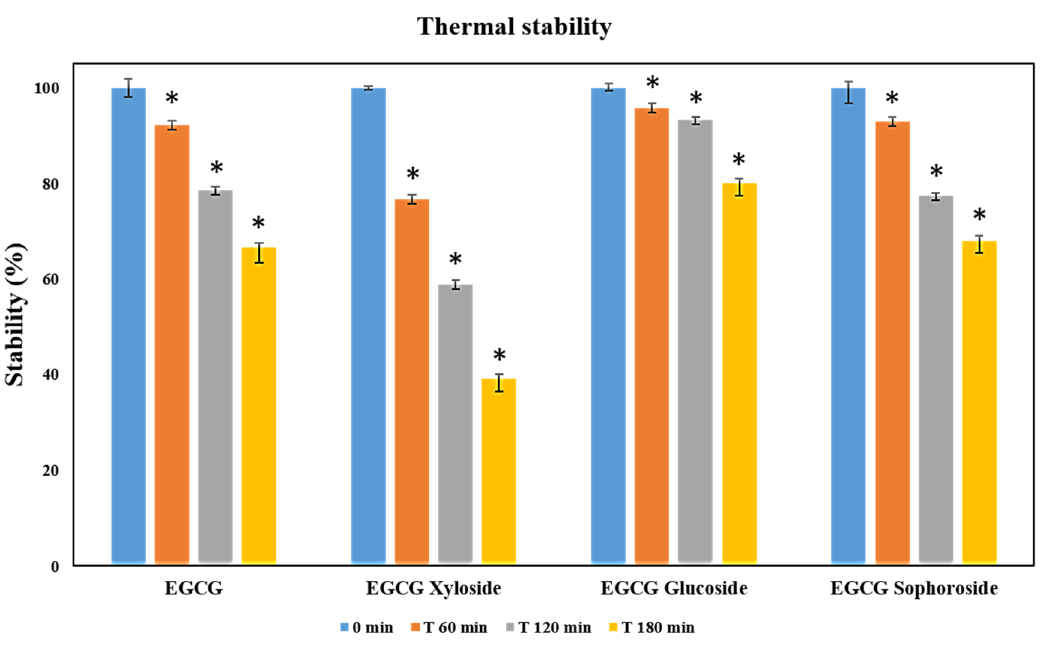
Figure 4. Thermal stability measured as relative degradation of EGCG and its glycosylated deriva- tives. In the study, 500 μM solutions of each molecule were incubated for 3 h at 70 °C. Student’s t - test: * p < 0.05 with respect to the 0 min measurement.